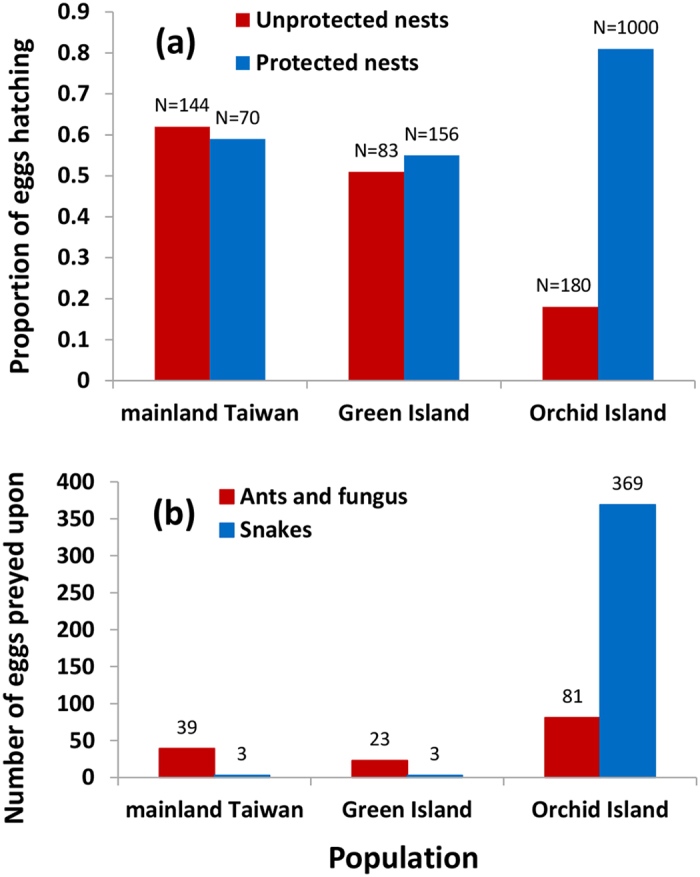
Predation rates of lizard nests and associated predators.Proportion of long-tailed sun skink eggs hatching from three populations without any form of nest protection ((a) for the mainland, Green Island, and Orchid Island, n = 108, 60, and 450 eggs) and when nests were protected by predator-excluding mesh (n = 1000, 70, and 156 eggs). Known causes of egg mortality, expressed as the numbers of eggs preyed on by snakes or ants and fungi (b).